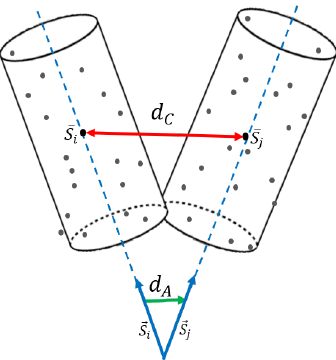
Figure 3. The aggregate distance d between two segments; the angular deviation d A is shown with green arrow and the spatial distance between point centroids d C with red